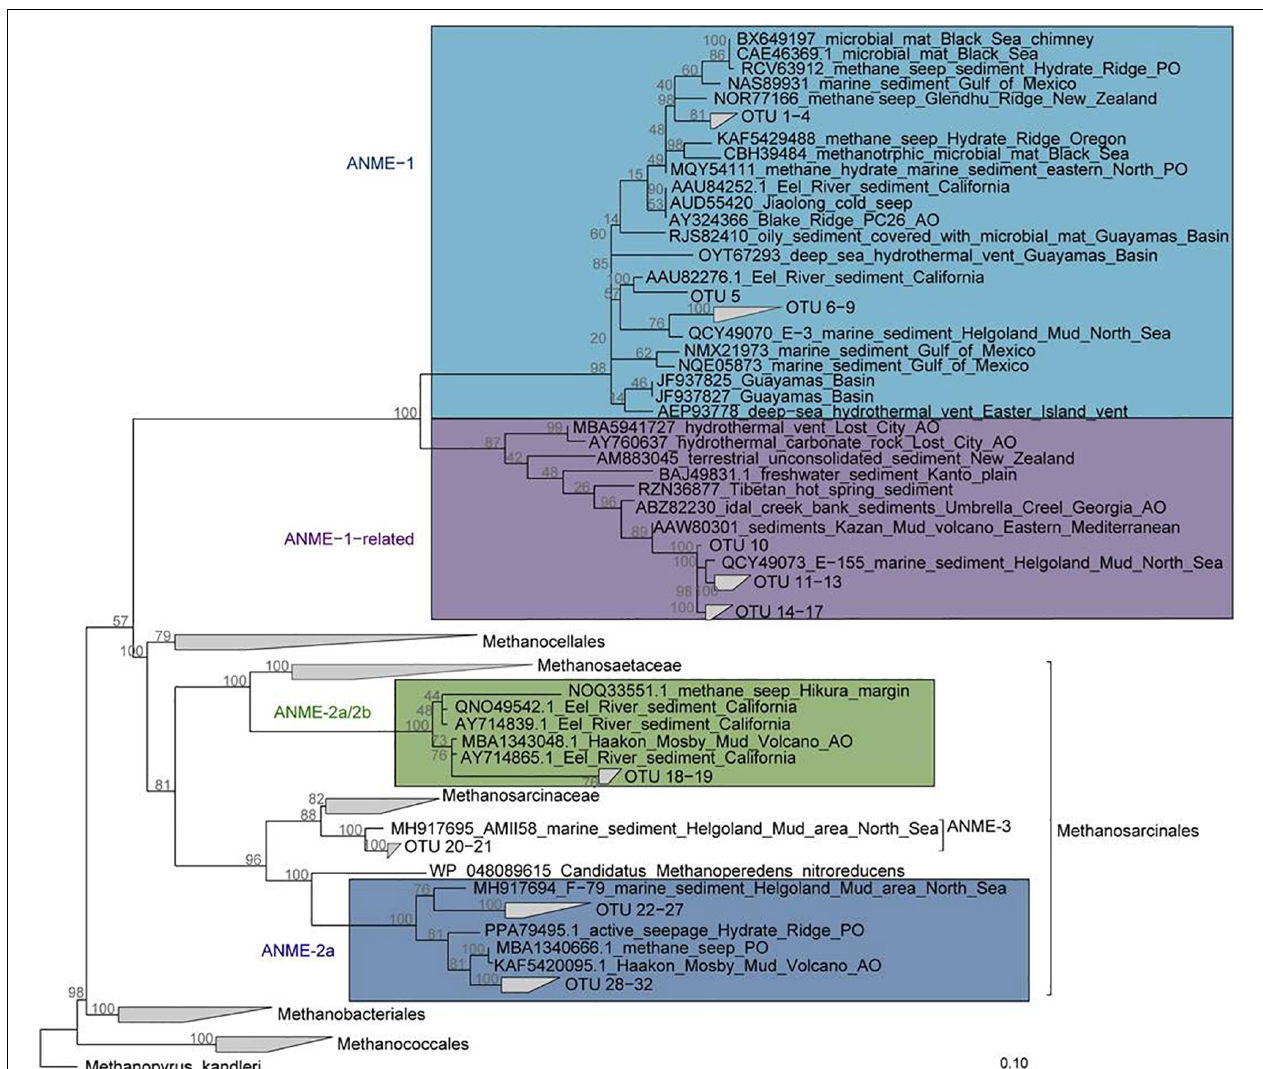
FIGURE 5 | Phylogeny of ANME subgroups. Maximum likelihood tree (RAxML, 1000 Bootstraps) based on in-house mcrA gene database. OTU sequences of South Georgia were implemented with ARB parsimony. The ANME subgroups relevant to this study are highlighted: ANME-1-related (purple), ANME (light blue), ANME-2a (marine), and ANME-2c